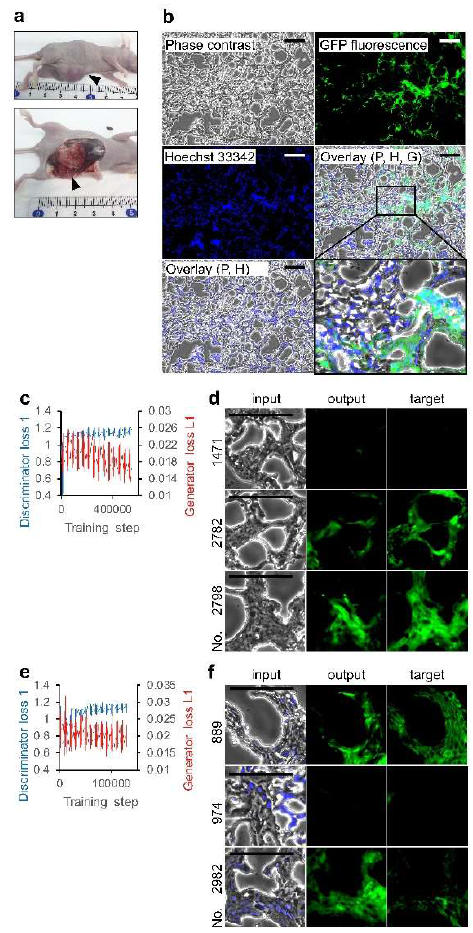
Figure 4. Deep learning of miPS-T47Dcm cell morphology in tumor tissue. ( a ) Primary subcutaneous tumors; arrowhead indicates tumor tissue. ( b ) Tumor tissue section visualized with phase contrast, Hoechst 33342, and GFP fluorescence using objection lens 20×. P: phase contrast; H: Hoechst 33342; G: GFP. Bars = 100 μm. An area in overlay (P, H, G) is shown in detail. ( c , e ) Effect of training steps on loss functions. ( d , f ) Output examples by AI models. Test phase contrast images were subjected to AI models for depicting fluorescence images. Input and target are the pair image for the depicted image evaluation. The AI models trained with the set of ( c , d ) phase contrast and GFP images, and ( e , f ) Hoechst 33342 overlaid-phase contrast and GFP images. Bars = 100 μm.